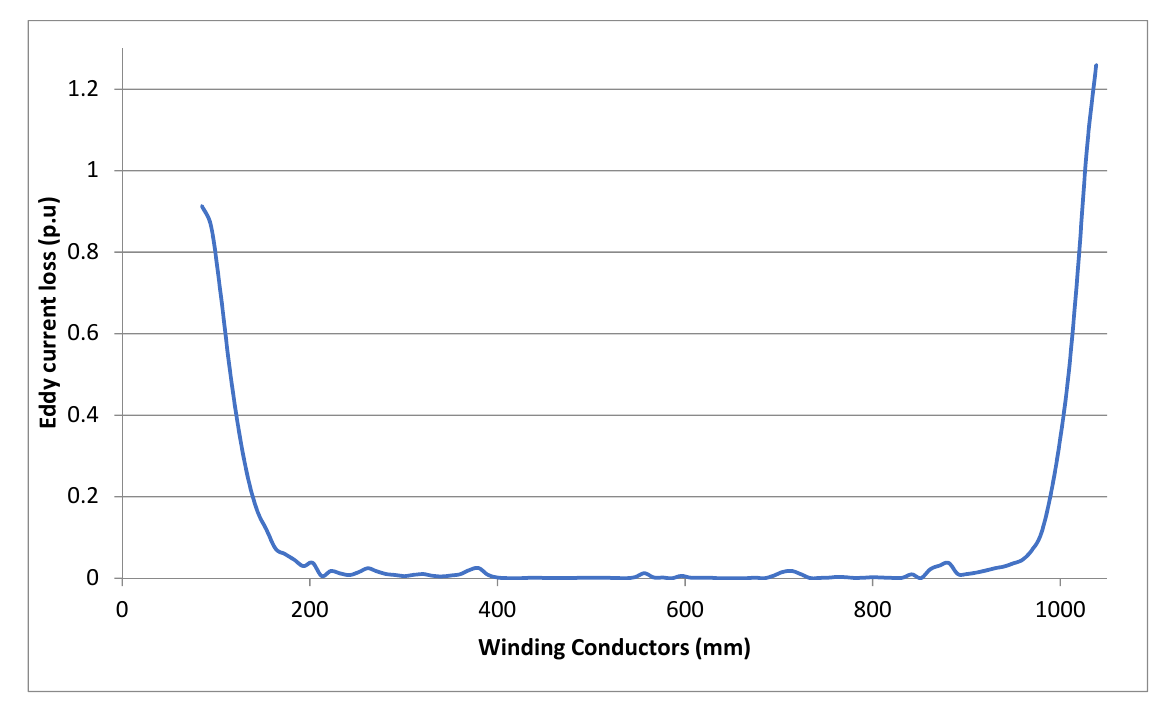
Figure 7. Eddy current loss distribution on the inner winding.